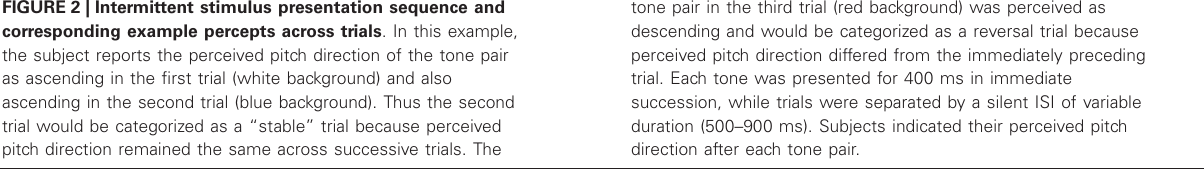
tone pair in the third trial (red background) was perceived as descending and would be categorized as a reversal trial because perceived pitch direction differed from the immediately preceding trial. Each tone was presented for 400 ms in immediate succession, while trials were separated by a silent ISI of variable duration (500–900 ms). Subjects indicated their perceived pitch direction after each tone